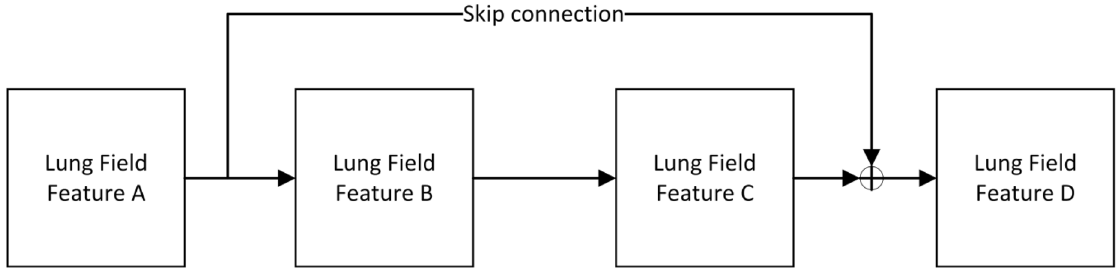
Figure 1. The principle of the residual